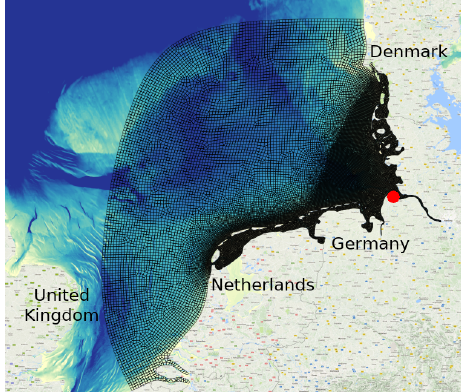
Figure 10. The area of the southeast North Sea experiment with mesh (black lines). The red dot indicates the position of the Cux- haven station. This mesh includes 31406 quads and 32